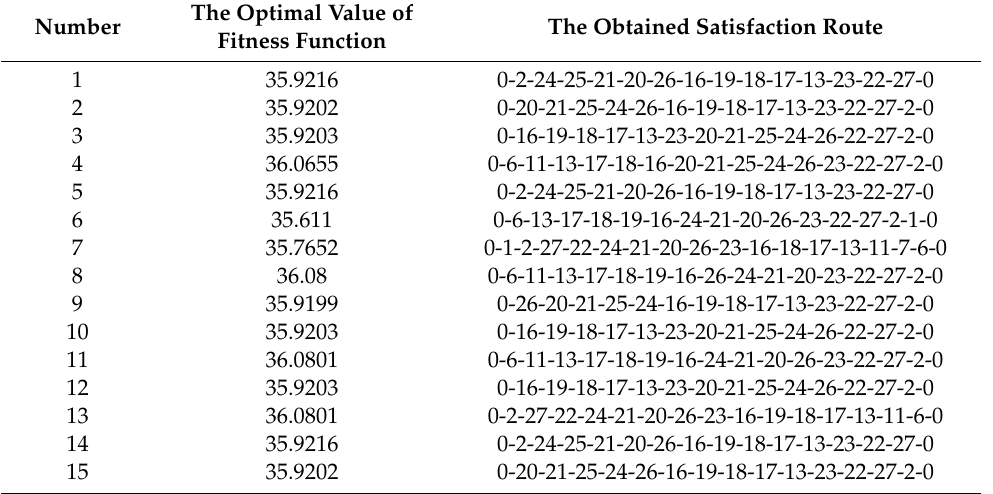
Table 6. The results of 15 tests using the APGA (28 attractions).